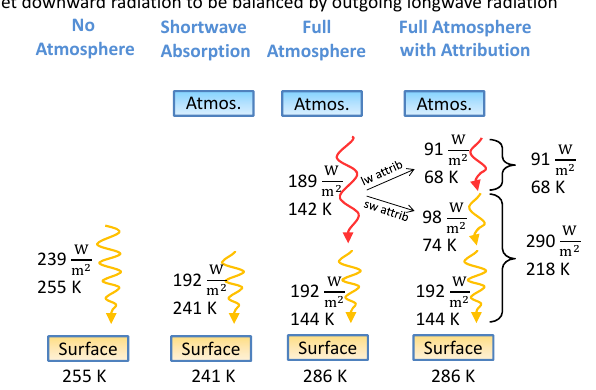
Fig. 5. Shortwave (net) and longwave (downward) fluxes at the sur- face (Wm − 2 ) and respective surface temperature contribution (K) for the case without an atmosphere (left) with an atmosphere only absorbing in the shortwave (second left), with a full atmosphere (second right) and additionally temperatures attributed to longwave and shortwave radiation. The surface temperature leads to an up- ward longwave radiation, which has to be balanced by the net short- wave and longwave fluxes.